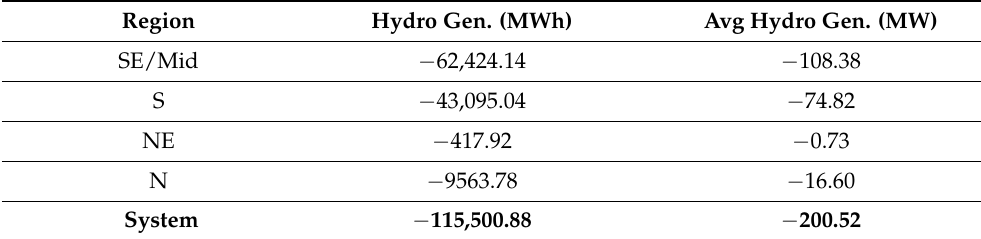
Table 5. Hydro generation differences between DR case and base case.